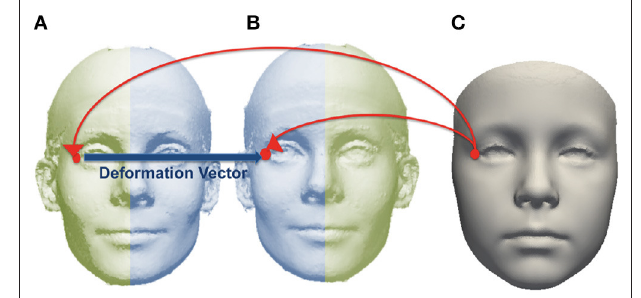
FIGURE 2 | Example of corresponding point mapped from an average image (C) to subject mesh (A) and mirrored copy (B) . The asymmetry flow vector is defined between corresponding points on the subject mesh and its mirrored copy.